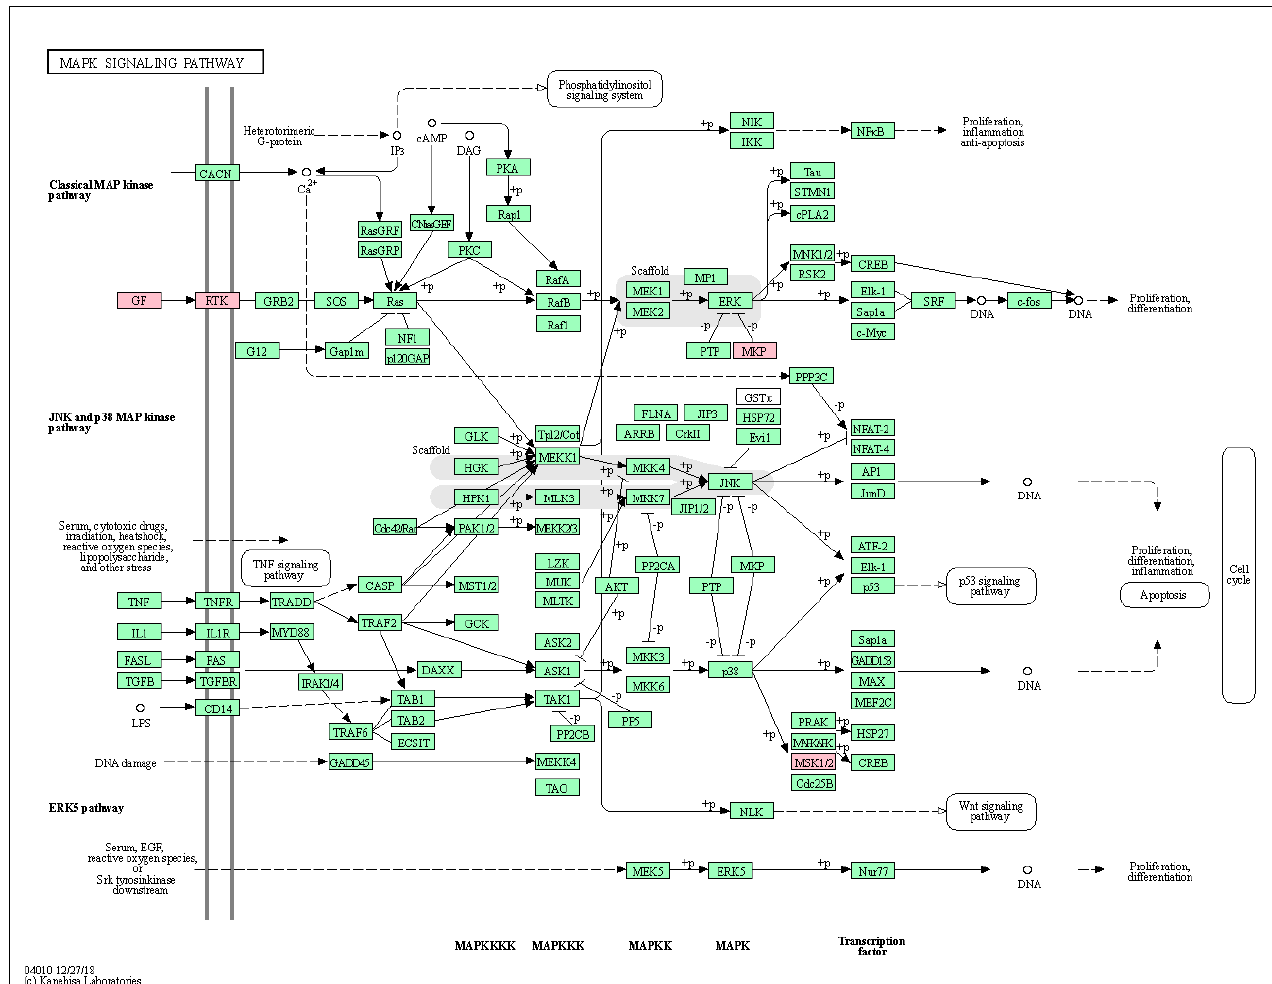
Figure 7. Signaling pathway.